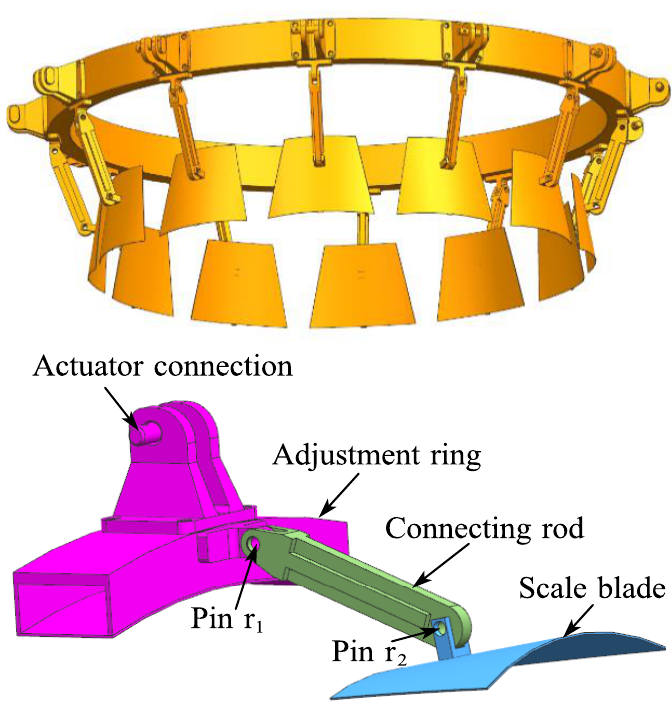
Figure 1. Full model and simplified model of adjusting mechanism.